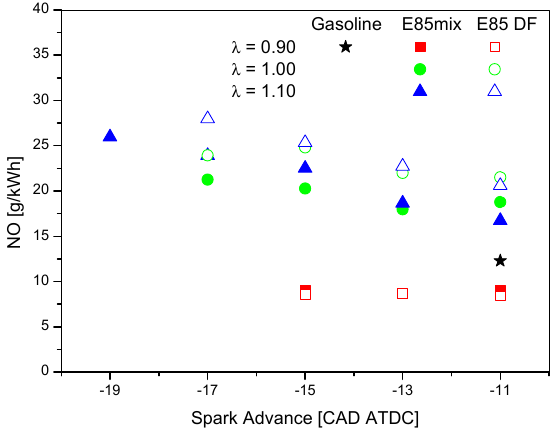
Figure 9. NO emissions against the spark advance at different λ .